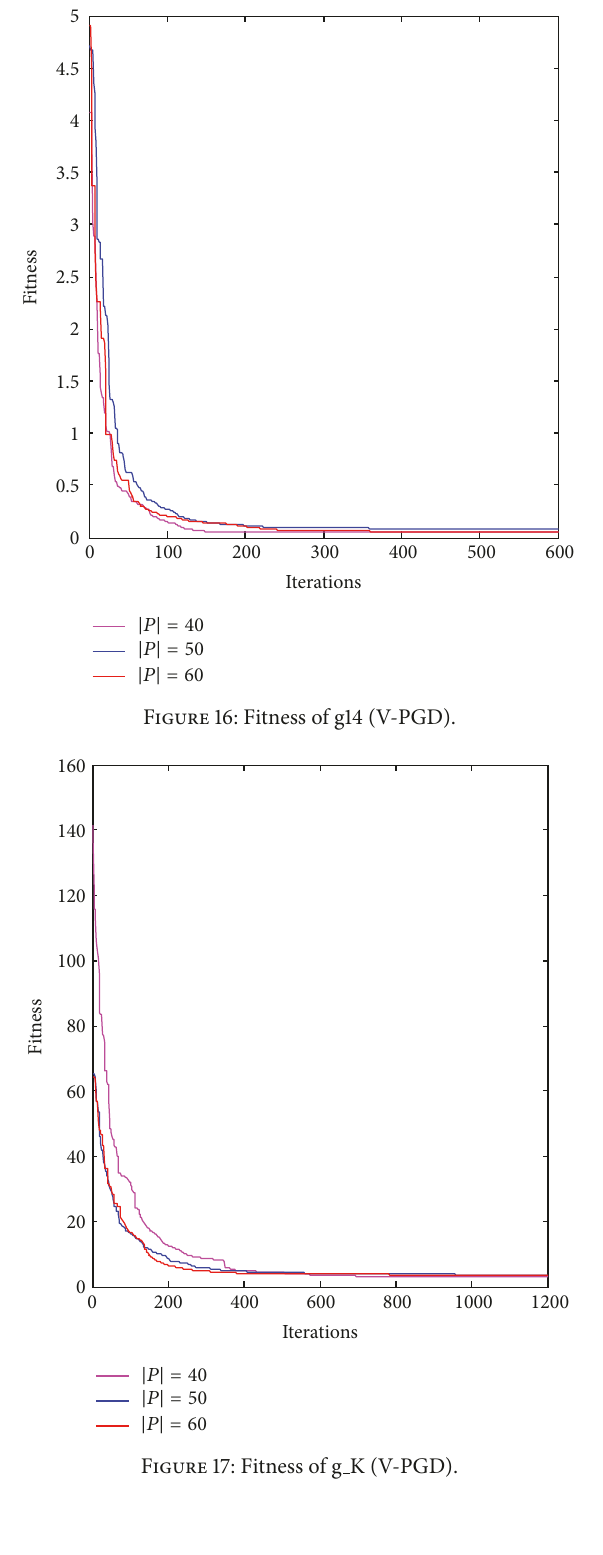
(v) The running times of the two PSO procedures both increase linearly as the number of vertices increases. However, the running time of S-PGD increases much faster than that of